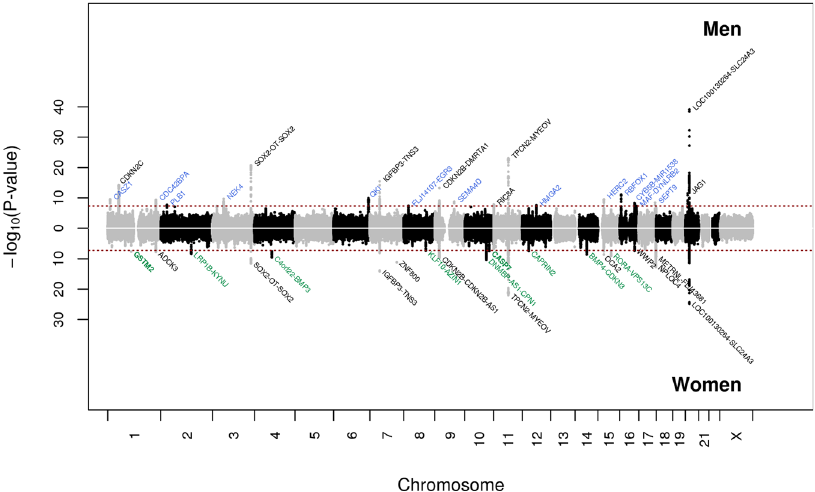
Fig. 2 Chicago plot of the sex-strati fi ed multiethnic GWAS meta-analyses of cataract. Results from the meta-analysis combining men from GERA and UKB are presented on upper panel, while results from the meta-analysis combining women from GERA and UKB are presented on the lower panel. The y- axis represents the -log 10 ( P -value); all P -values derived from logistic regression model are two-sided. The red dotted line represents the threshold of P = 5 × 10 − 8 which is the commonly accepted threshold of adjustments for multiple comparisons in GWAS. Locus names in black are for those previously reported. Locus names in bold ( CASP7 and GSTM2 ) are for the additional novel loci speci fi c to women (compared to the multiethnic meta-analysis (GERA + UKB)). Novel loci signi fi cantly associated ( P < 5 × 10 − 8 ) with cataract in women are highlighted in green, and those signi fi cantly associated with cataract in men are highlighted in